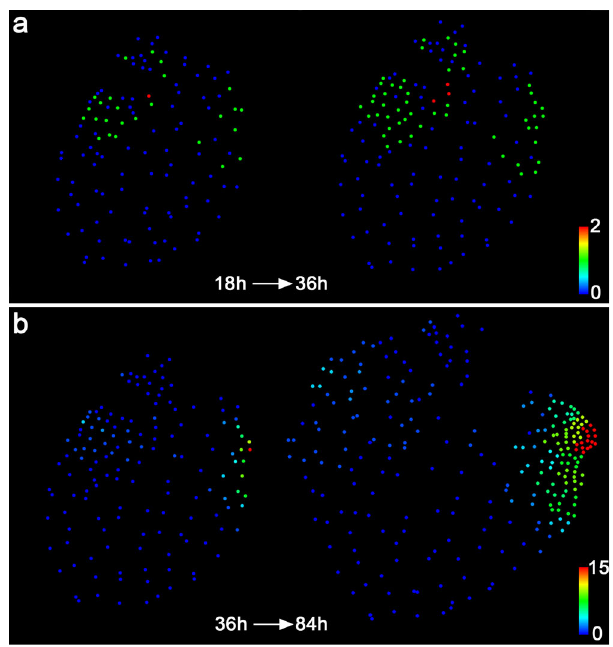
Fig. 9 Quanti fi cation of cell division events in the ablated Ceratopteris gametophyte. Each dot represents the location of the segmented individual nucleus shown in Fig. 8. Quanti fi cation of cell division events in the following time frames from 18 – 36 h ( a ) and 36 – 84 h ( b ). The quanti fi ed cell division events are shown in the images from the fi rst (left panel) and last (right panel) time points of the indicated intervals. Colors indicate the number of cell division events in each cell lineage during the indicated time intervals, with the scale from blue (0) to red (2) ( a ) and from blue (0) to red (15) ( b